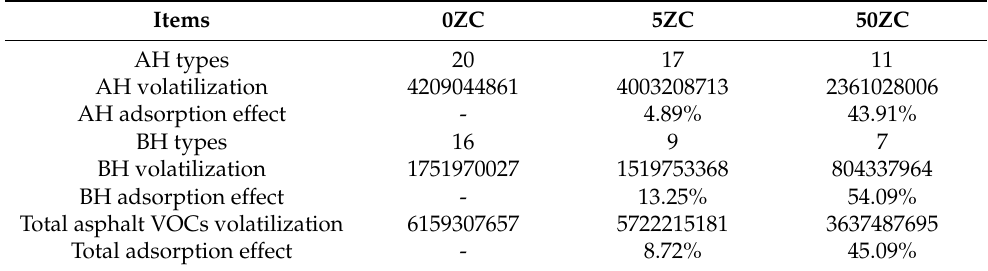
Table 3. Adsorption efficiencies of asphalt